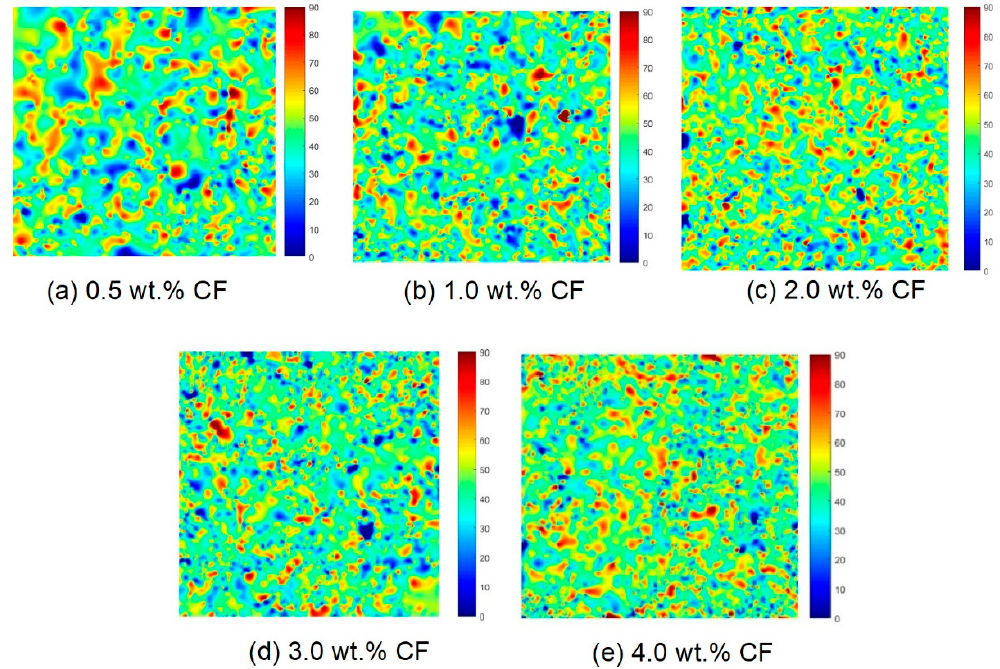
Figure 16. Nephogram of the orientation angles of the carbon fibers (Unit: °) in the contact-hardening composites with different carbon fiber contents: ( a ) 0.5 wt.%; ( b ) 1.0 wt.%; ( c ) 2.0 wt.%; ( d ) 3.0 wt.%; ( e ) 4.0 wt.%.